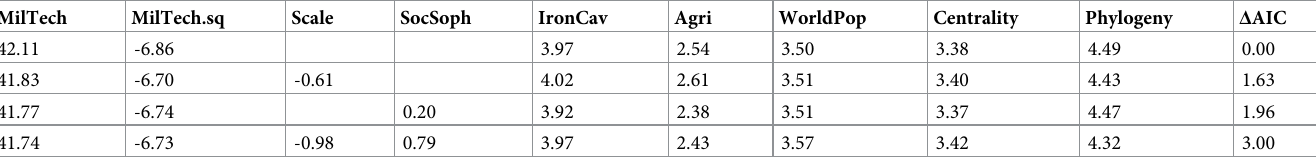
The table shows t-statistics associated with each of the predictors (column headings) for the best models with Δ AIC (the AIC difference with respect to the best model) less than 2. The best model by AIC is included as the top row. An empty entry indicates that the term associated with this predictor is not included in the